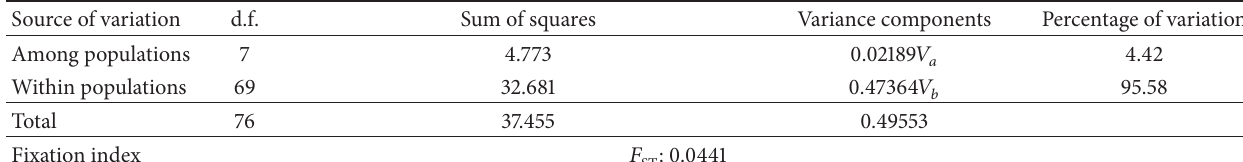
Table 3: Hierarchal analysis of molecular variance (AMOVA) for T. ilisha .